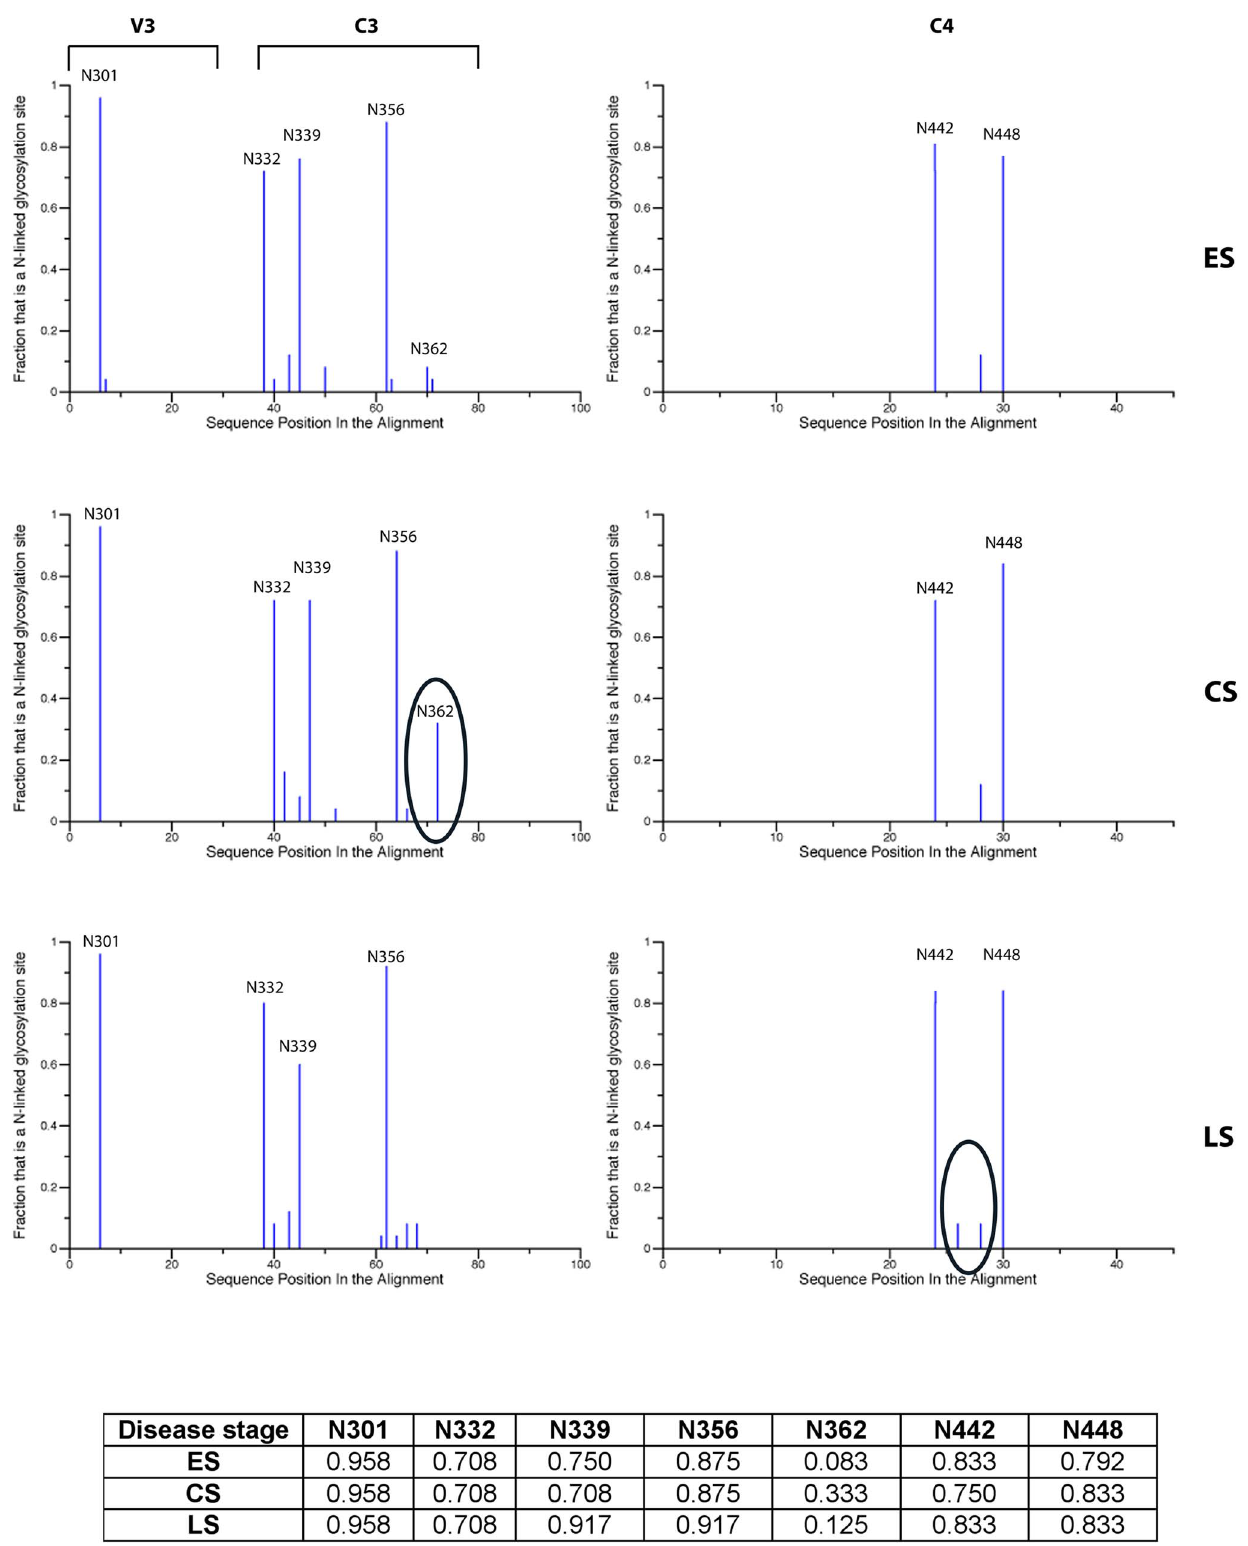
Figure 2. Distribution of PNGS in V3, C3 and C4 regions of gp120 in HIV-1 clade C variants obtained during different disease stages. Table at the bottom reports the frequency of presence of each PNGS. PNGS position in the alignment is according to the HXB2 amino acid sequence numbering. Circles highlight a significant increase of shifting PNGS frequency ES = Early disease Stage CS = Chronic disease Stage LS = Late disease Stage.